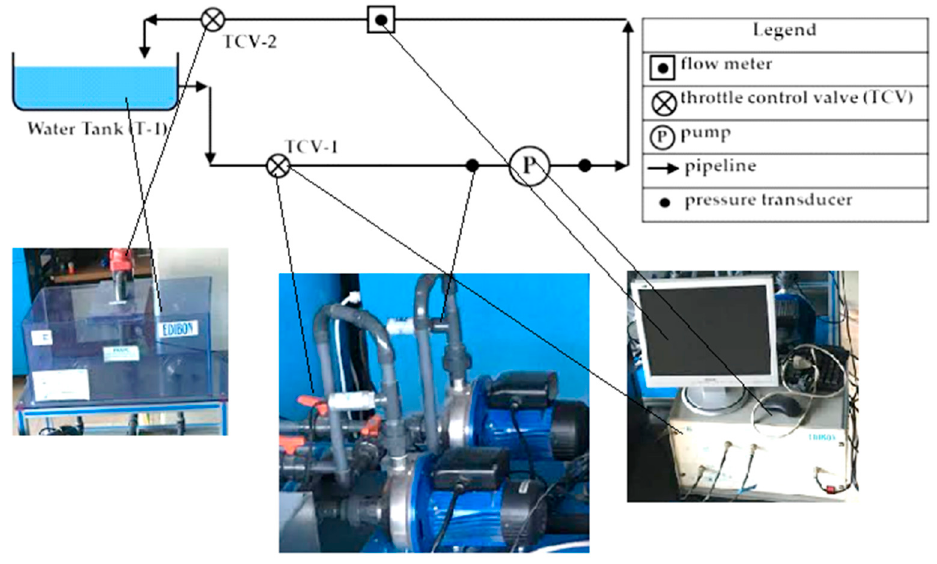
Figure 8. Figure 8. Scheme of the base pumping system (BPS) in the mathematical model and experimental apparatus.